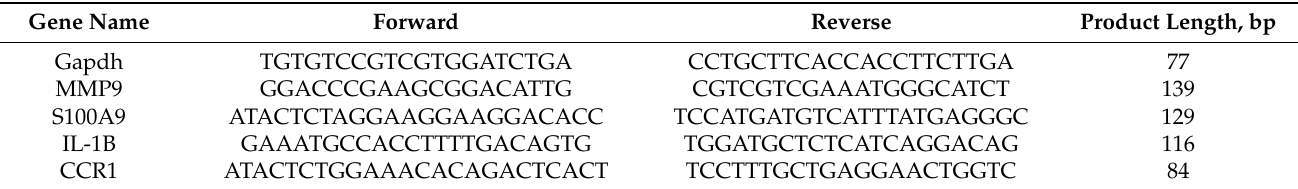
Table 1. Primers for quantitative polymerase chain